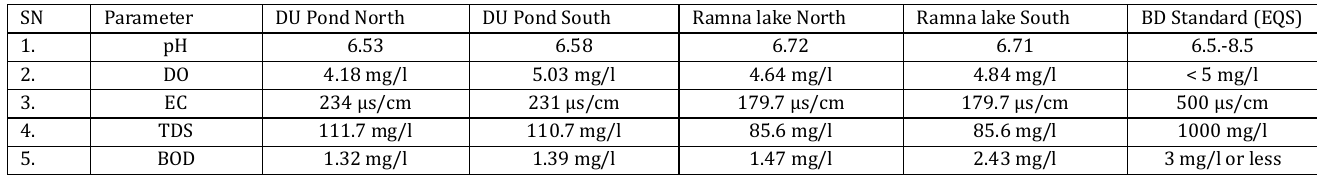
Table 1: Result of Physicochemical